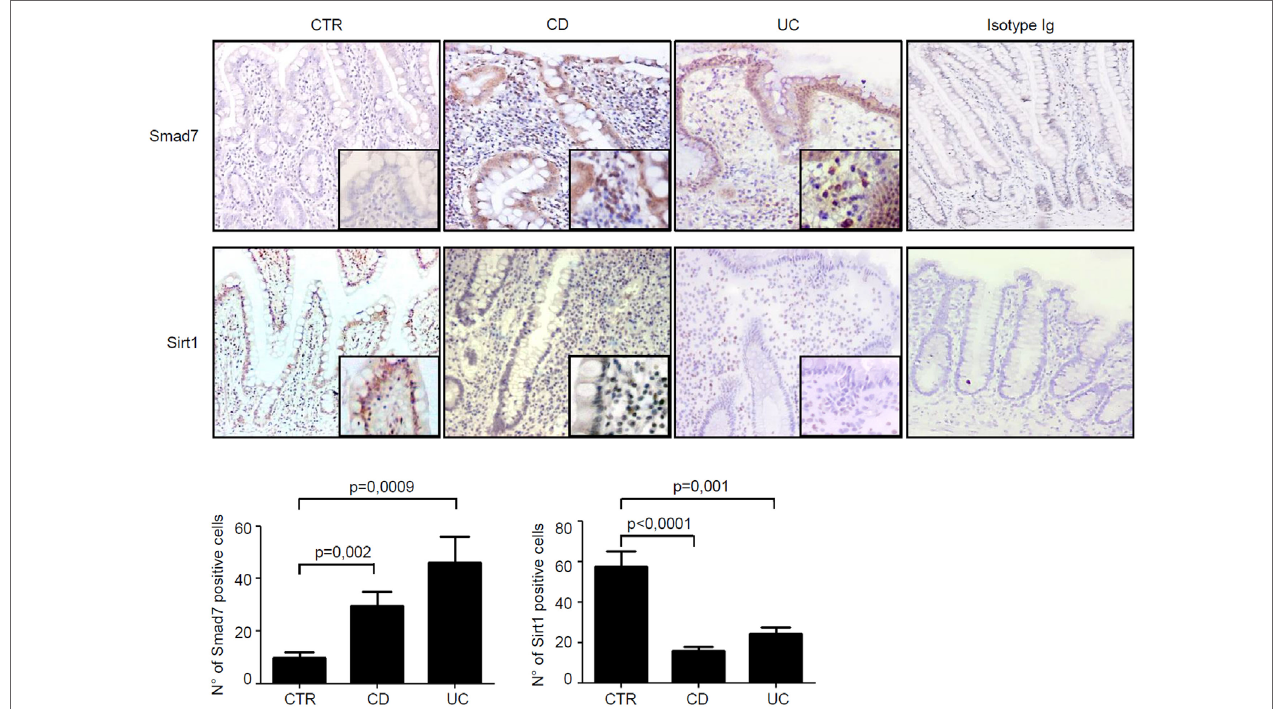
FigUre 2 | In inflammatory bowel disease, the increased expression of Smad7 associates with reduced expression of Sirt1 in both epithelial and lamina propria compartments. Representative photomicrographs (100 × , original magnification) of Smad7 and Sirt1-stained paraffin-embedded sections of biopsy samples taken from one control (CTR), one patient with Crohn’s disease (CD), and one patient with ulcerative colitis (UC). Sirt1-positive cells are evident in both the epithelial and lamina propria compartments in CTR, while Smad7-positive cells are more abundant in both the epithelial and lamina propria compartments of CD patients and UC patients. Higher magnification photomicrograph (200 × ) is shown in the insert. Staining with control IgG is also shown. The Smad7 and Sirt1-positive cells were manually counted in at least four fields per each section taken from six CTR, six patients with CD, and six patients with UC. Data indicate mean ±